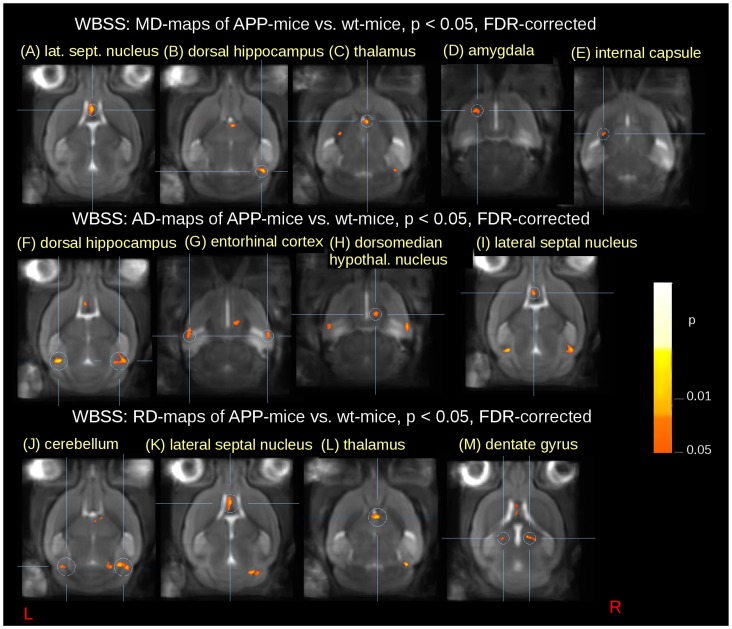
Results from whole brain-based spatial statistics (WBSS) of MD-, AD-, and RD-maps of APP mice vs. wt mice at p<0.05, FDR corrected (coronal views).Reduction is displayed in hot colors. (A–E) MD reduction in the lateral septal nucleus, the dorsal hippocampues, the thalamus, the amygdala, and the internal capsule, respectively; (F–I) AD-reduction in the dorsal hippocampus (bihemispheric), the entorhinal cortex (bihemispheric), the dorsomedian hypothalamic nucleus region, and in the lateral septal nucleus, respectively; (J–M) RD-reduction in the cerebellum (bihemispheric), the lateral septal nucleus, the thalamus, and the dentate gyrus, respectively.